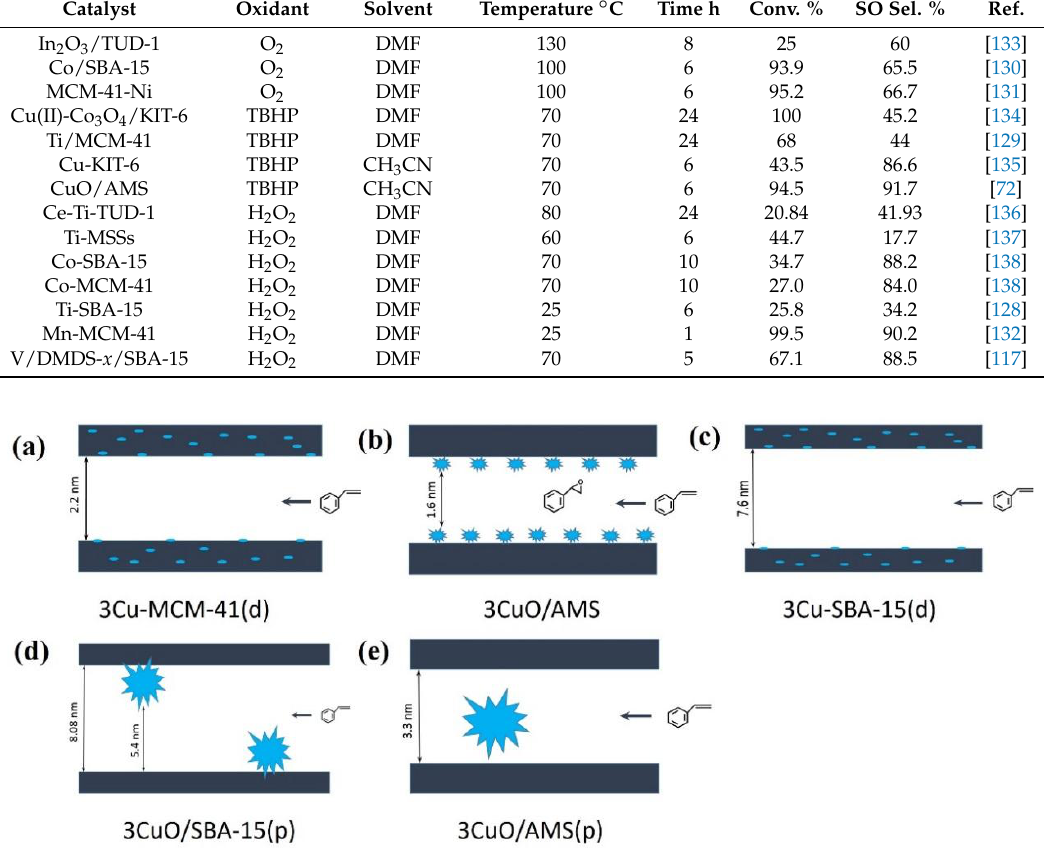
Figure 16. Depiction for the diffusion of styrene inside the pore channels of different catalysts in epoxidation process: ( a ) 3Cu-MCM-41( d ), ( b ) 3CuO/AMS, ( c ) 3Cu-SBA-15(d), ( d ) 3CuO/SBA-15(p), ( e ) 3CuO/AMS(p). Table 2. Catalytic properties of different catalysts on styrene oxidation.